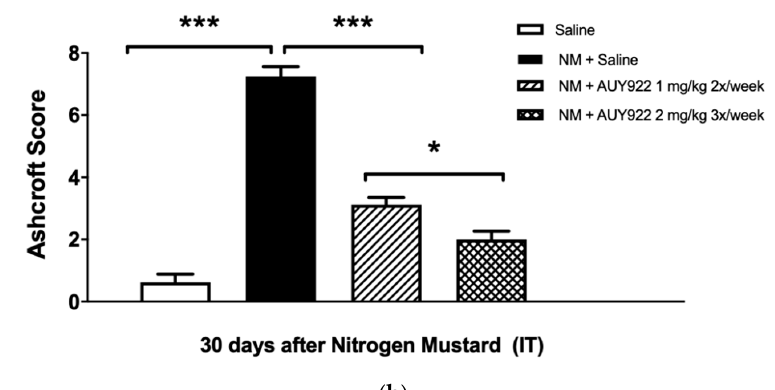
Figure 3. Histological analysis of lung injury after intratracheal administration of 0.625 mg/kg NM or saline followed by treatment, starting 24 h later, with either saline or the HSP90 inhibitor AUY-922 (1 mg/kg 2×/week or 2 mg/kg 3×/week i.p.) for 10 or 30 days. Masson’s trichrome staining of lung